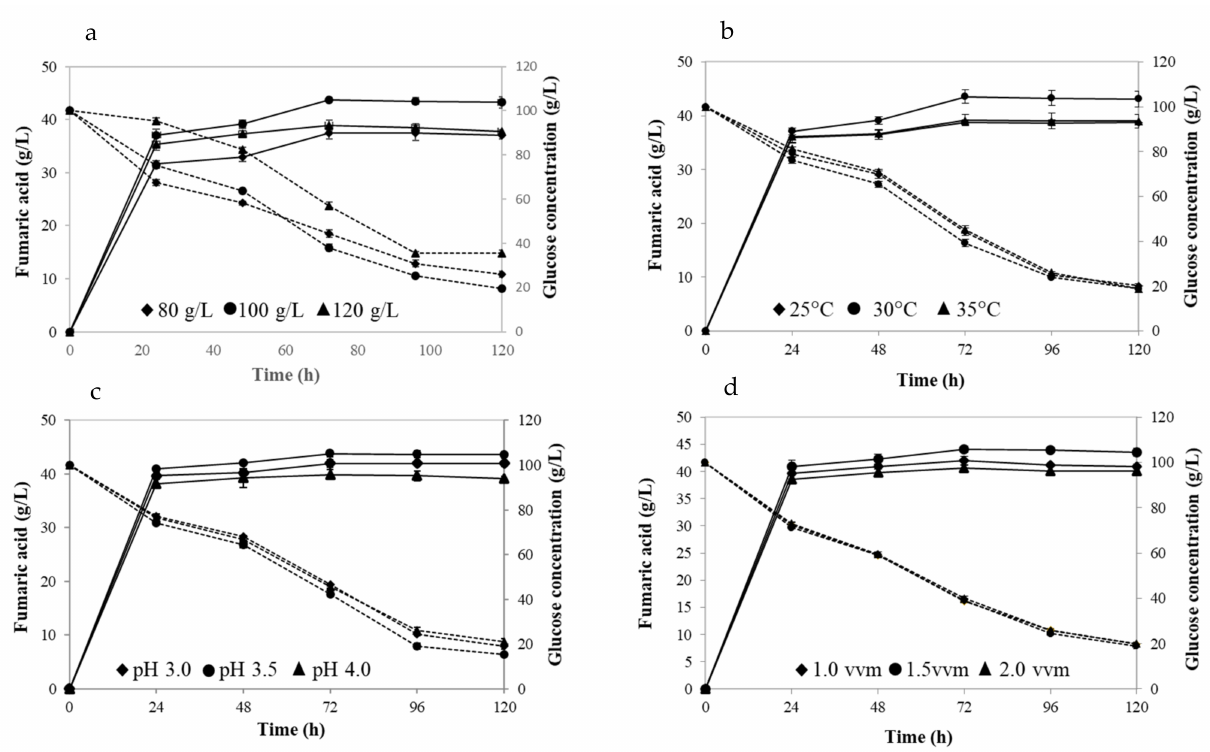
Figure 1. Fumaric acid concentration (solid line) and remaining glucose (dash line) at various initial glucose concentrations (g/L) ( a ), temperature ( b ), pH ( c ), and aeration rate ( d